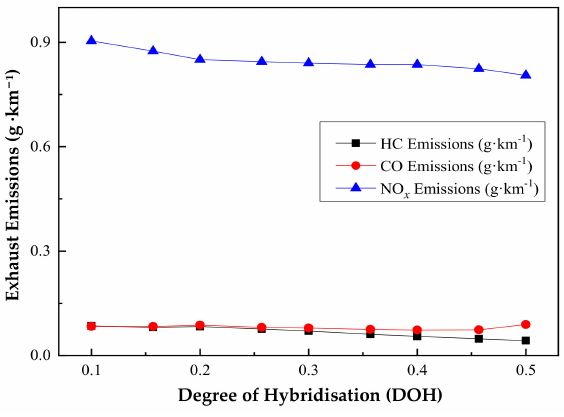
Figure 18. Curves of emission with